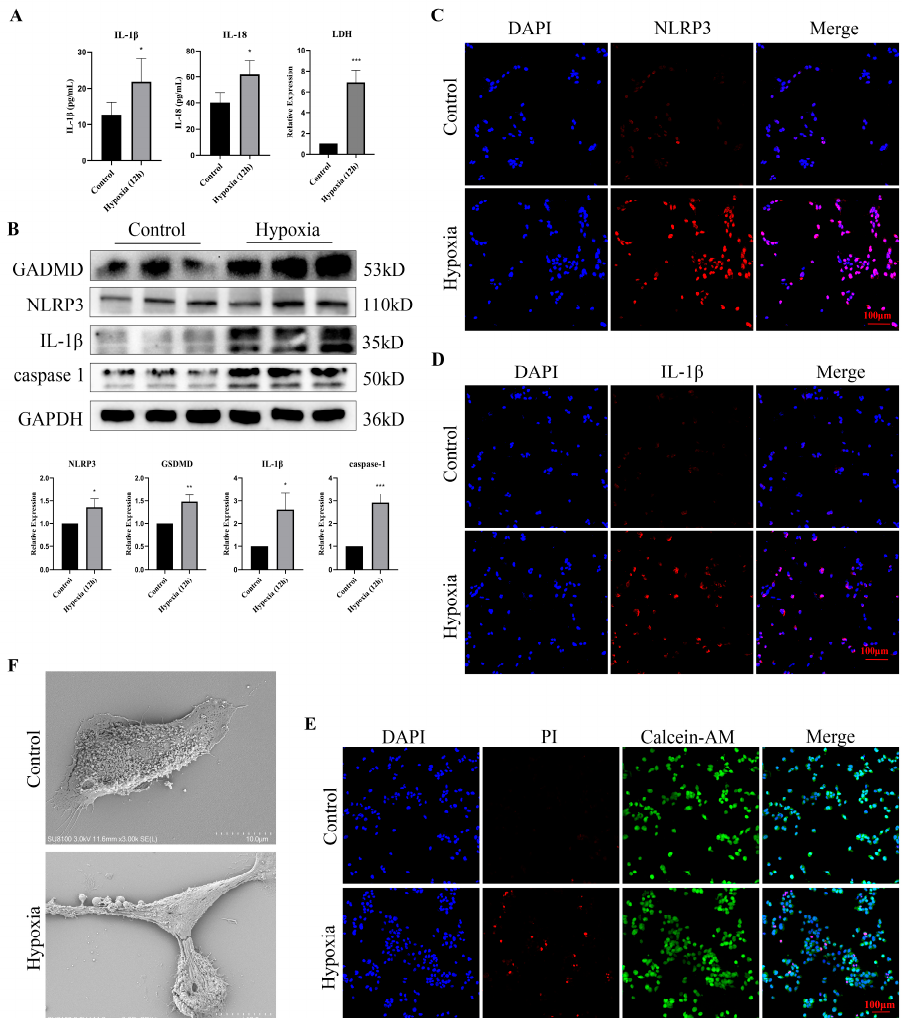
Figure 6. Hypoxic exposure led to epithelial cell pyroptosis. ( A ) The levels of IL-1 β , IL-18 and LDH 6 in the supernatant. ( B ) Western blot of pyroptosis-related proteins after hypoxic exposure 12h in epithelial cells. ( C ) Immunofluorescence of epithelial cells showed upregulation of NLRP3 after hypoxic exposure for 12 h. ( D ) Immunofluorescence of IL1 β in epithelial cells after hypoxic exposure for 12 h. ( E ) Calcein AM/PI staining of epithelial cells after hypoxic exposure for 12 h. ( F ) Scanning electron microscopy showed that after hypoxic exposure for 12 h, the morphology of epithelial cells changed, with pyroptotic morphology characterized by pyroptotic bodies. Data are presented as the mean ± S.D. (n ≥ 3). * p < 0.05; ** p < 0.01; *** p < 0.001. Scale bars, 100 µ